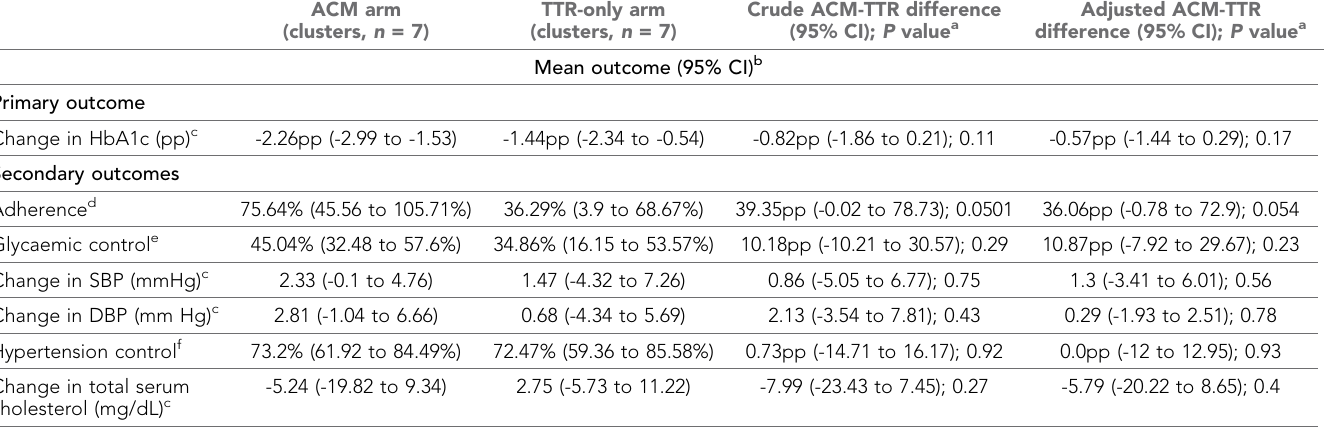
Table 2. Primary and secondary outcome